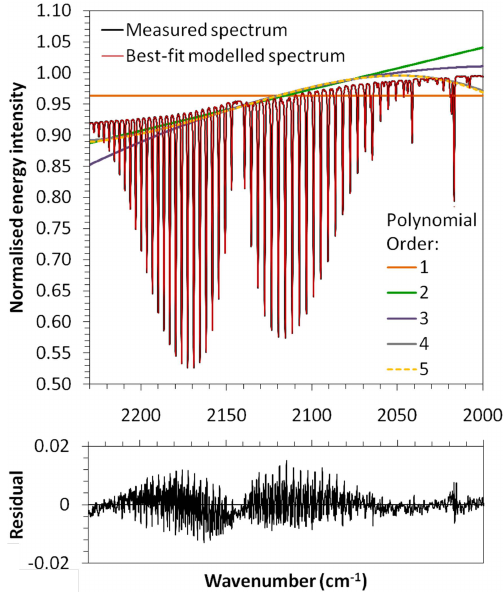
Fig. 3. Examples of results from a measured spectrum and the best- fit modelled spectrum produced using the MALT forward model and nonlinear least squares (NLLS) fitting procedure described in Griffith (1996). The case shown is for 482ppmm of CO at a gas pressure of 1000hPa. Top: The measured and best-fit modelled spectra are shown to be well matched, with the different background polynomial functions (orders 1–5) tested also shown. The fourth or- der polynomial provided the best match to the measured spectrum, and this was used to simulate the best-fit modelled spectrum shown. Bottom: The residual spectrum (i.e. the measured spectrum sub- tracted from the modelled spectrum), which is used to provide a measure of fitting accuracy. The spectral features in the residual are due to an imperfect fit between the modelled ILS and the non-ideal instrument